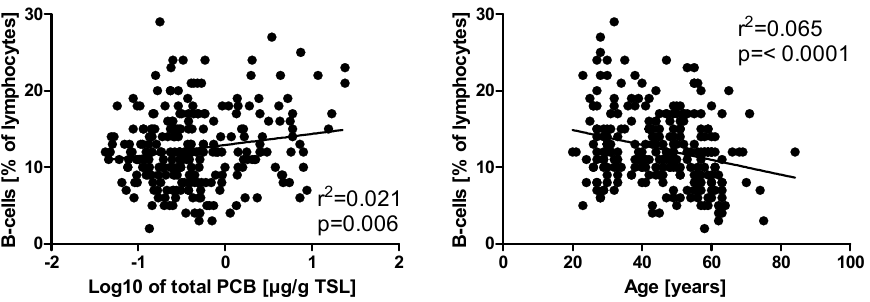
Figure 2. Correlation of the percentage of CD19+ B-cells among lymphocytes with total PCB burden and age. Lines represent the results of linear regression analysis.